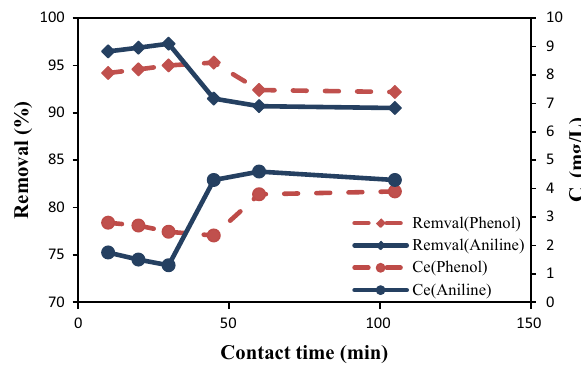
Fig. 5 Effect of contact time on removal efficiency of